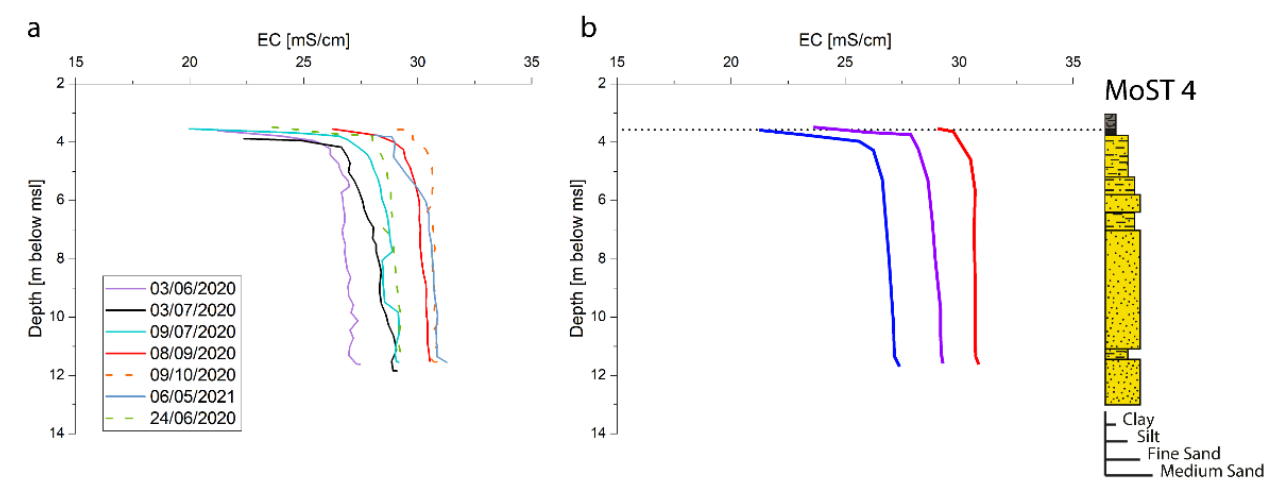
Figure 5. EC profiles collected in MoST4 well. Panel ( a ) shows the configurations assumed by the EC curve during the observed period. The model of panel ( b ) summarizes the configurations and compares them with the stratigraphic section, outlining the sedimentary constraint (dotted area) existing in the subsoil surrounding the monitoring